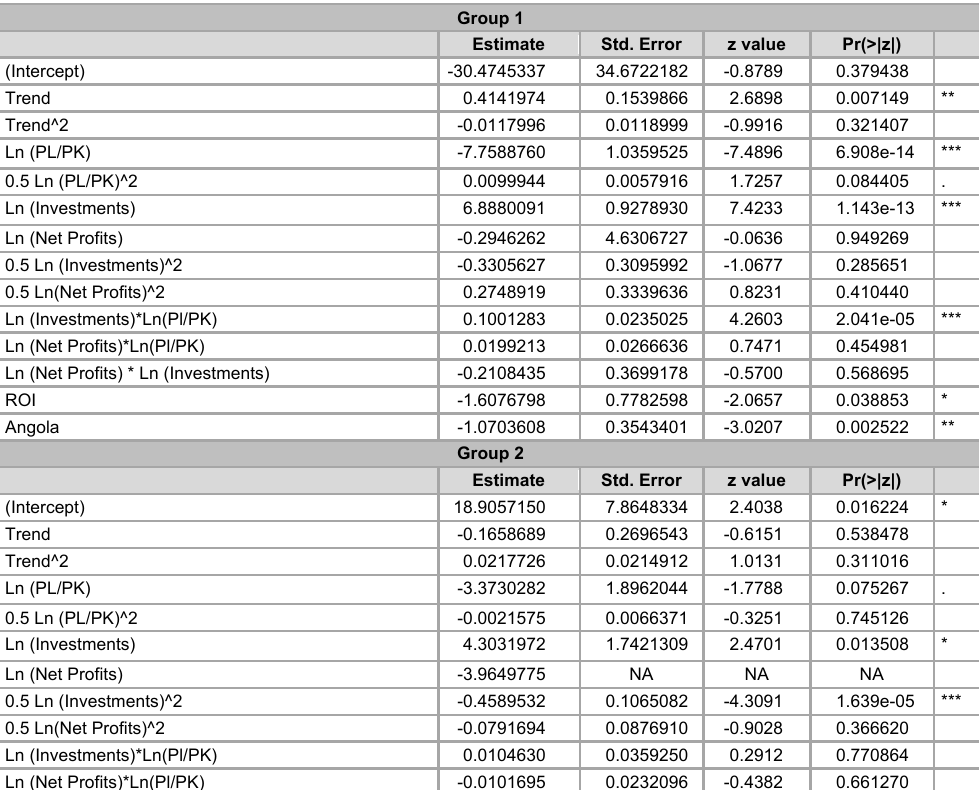
Latent class model results - translog cost function (dependent variable: Ln cost) Group